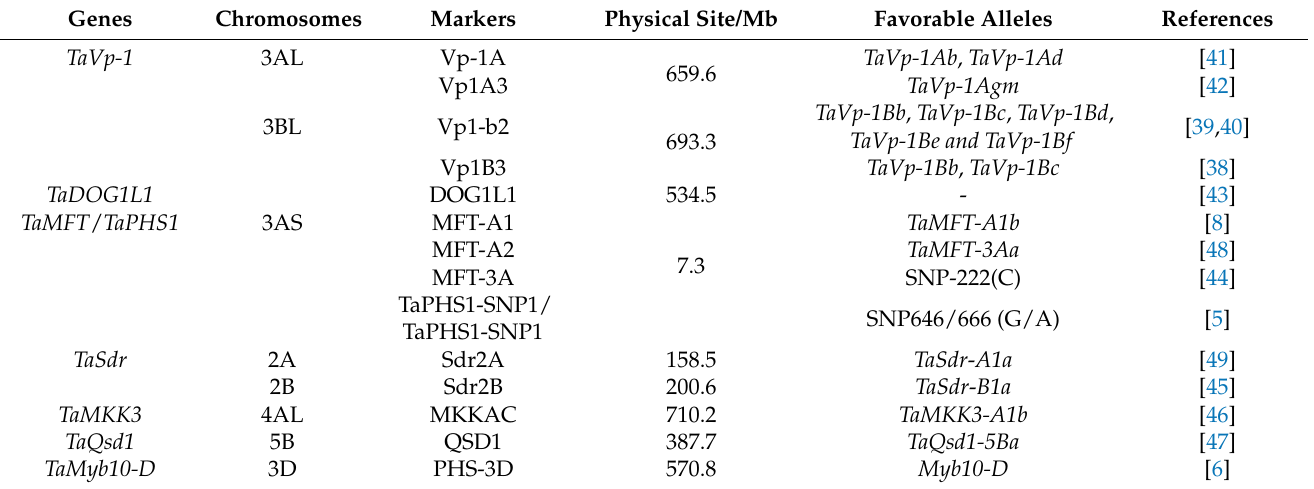
Table 2. The genes and their favorable alleles for pre-harvest sprouting PHS resistance in